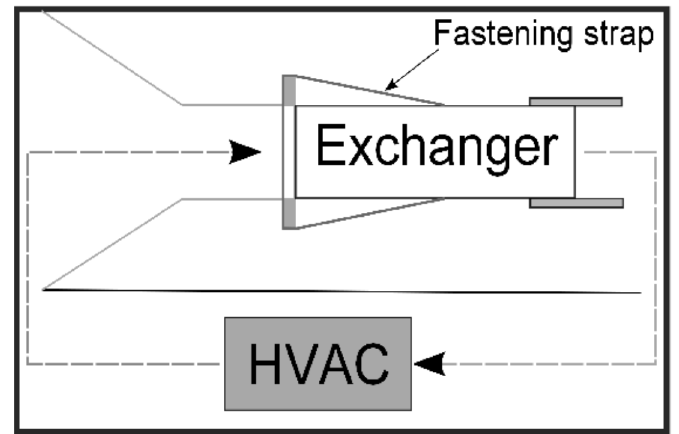
Figure 1. Scheme of the air supply system.